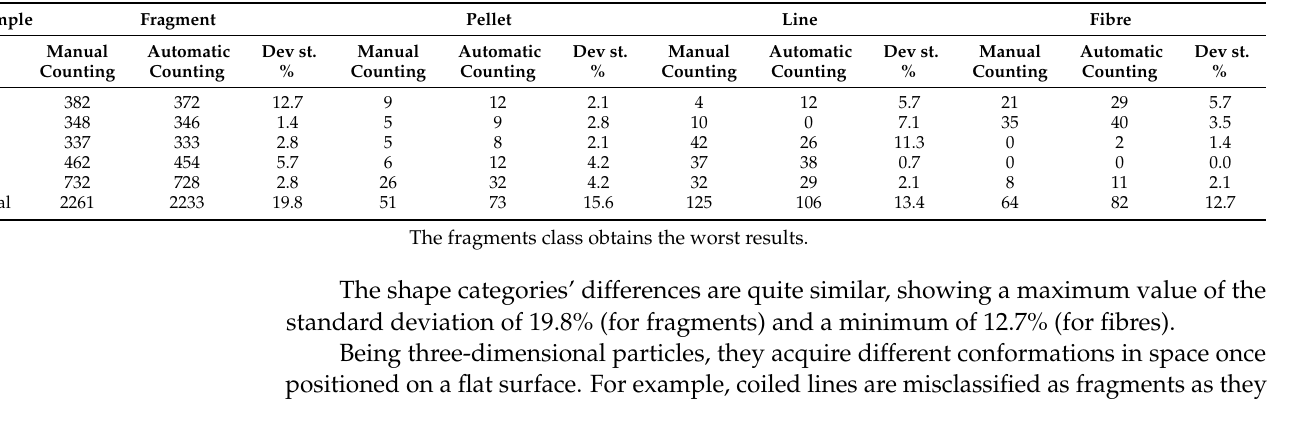
Figure 6. Manual vs. automatic classification results. Results are expressed as the sum of the different shape category in the five different samples. Table 2. Manual vs. automatic classification (early machine learning algorithm) results per